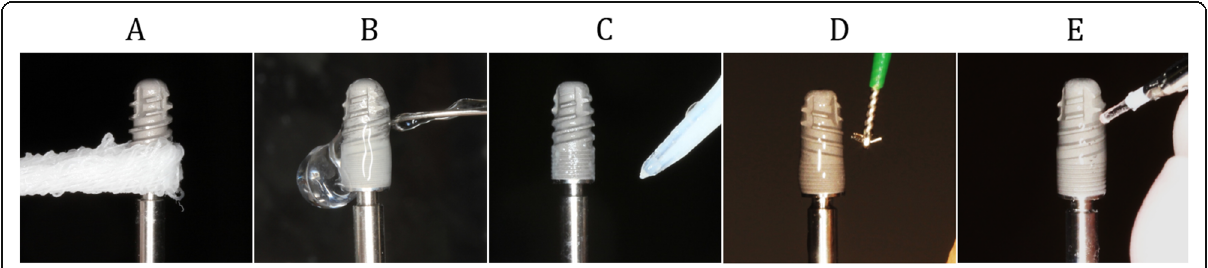
Fig. 3 Decontamination methods. a Gauze soaked in saline applied using a sawing motion. b Ultrasonic scaler (SUPRASSON P-MAX, Satelec- Acteon group, Bordeaux, France, power setting: P5, tip: Implant Protect IP3L/R). c Air abrasives (AIR-FLOW MASTER PIEZON ® , EMS, Nyon, Switzerland, power setting: water flow 100%, air pressure 75%, powder: AIR-FLOW ® PERIO POWDER, nozzle: PERIO-FLOW ® nozzles, distance from the nozzle to the implant 2 mm). d Rotary stainless steel instrument (iBrush, NeoBiotech©, Los Angeles, USA, rotating speed 1500 rpm). e Er:YAG laser (Erwin AdvErL, J.Morita©, Kyoto, Japan, power setting 60 mJ/pulse, 10 pps, tip: C600F, distance from the tip to the implant 2